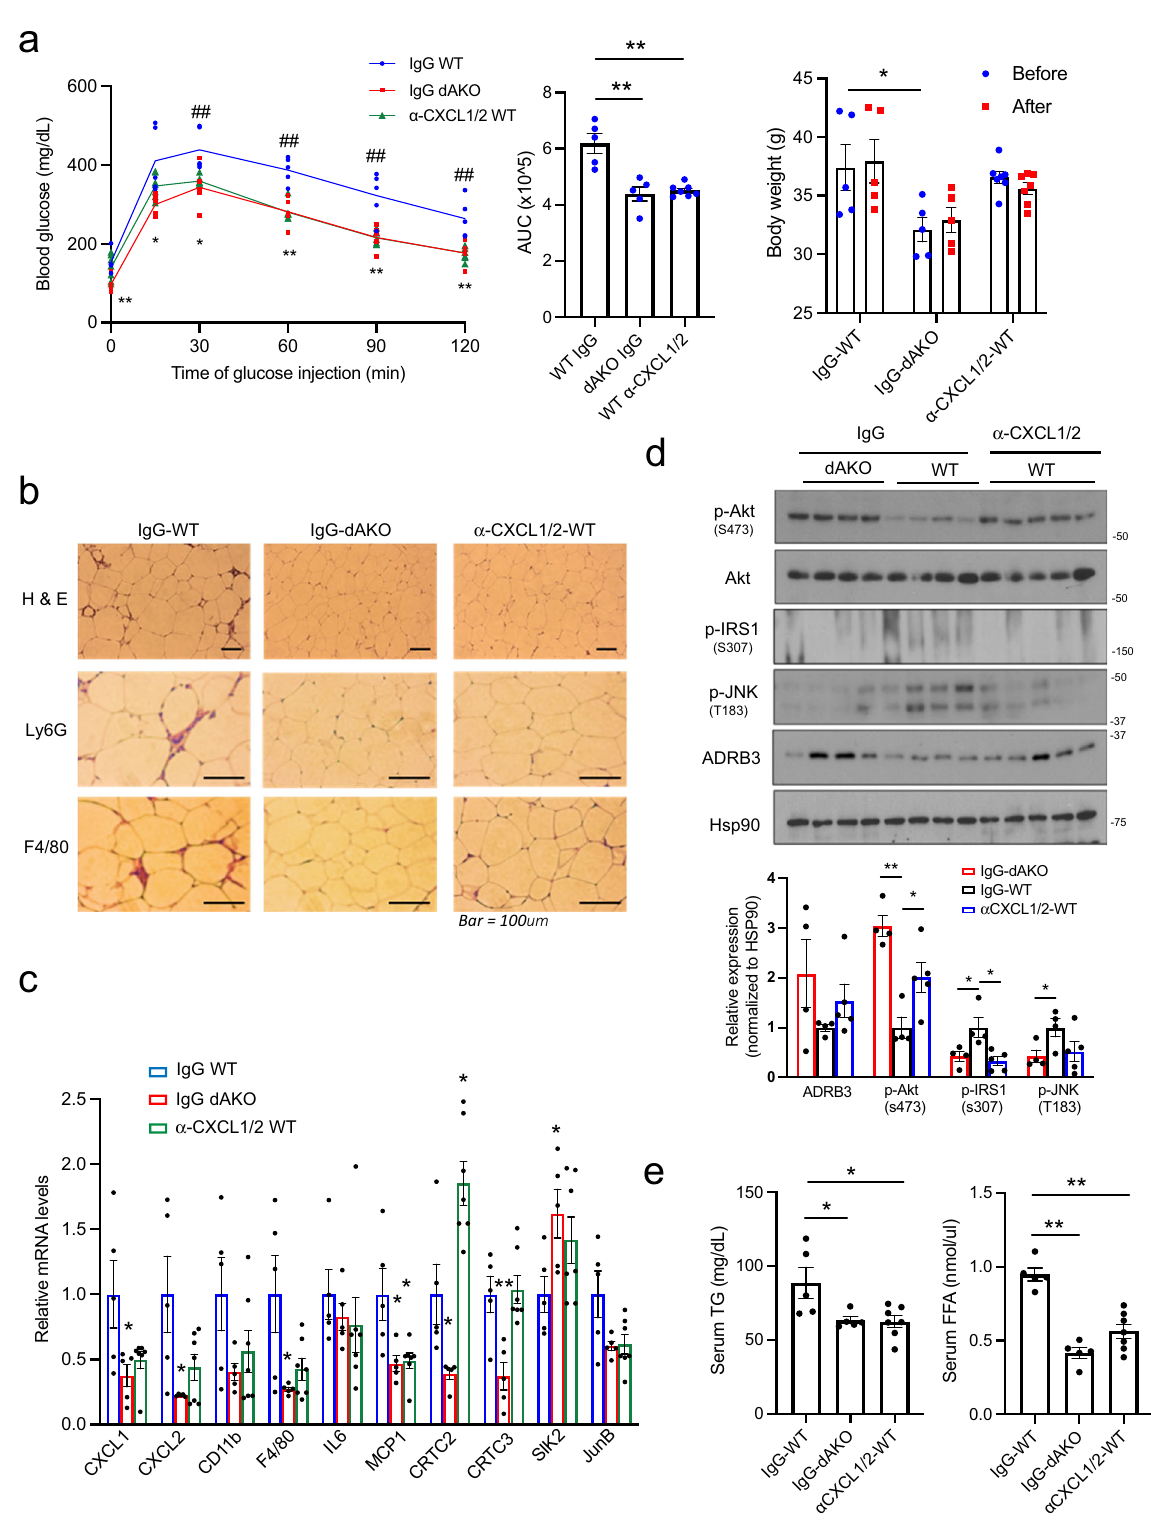
For High Fat Diet (HFD) feeding, 4 – 6-week-old mice were fed 60% HFD (Research Diet # D12492) for indicated periods with regular day/night cycles. For glucose tolerance testing (GTT), mice fed with a 60% high-fat diet were fasted overnight and injected with 1g/kg of glucose/body weight. Blood glucose levels were monitored at indicated time points for 2h. For insulin tolerance testing (ITT), mice were fasted for 4h and injected with 1 U/kg of insulin/body weight. Blood glucose levels were determined at indicated time points. Body fat composition was analyzed by